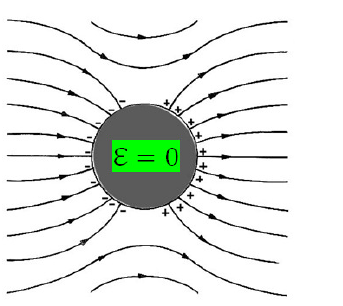
Figure 1. Electric field waves across Pt-wire (top view).